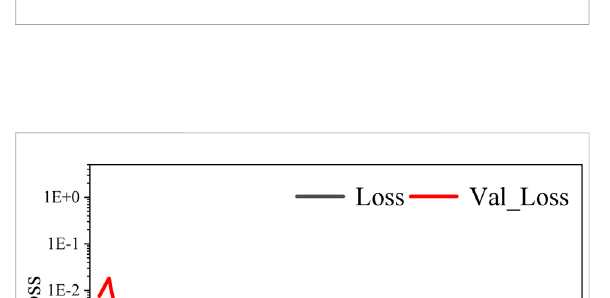
FIGURE 6 Trend of loss value of the training set ( Loss ) and loss value of the veri fi cation set ( Val_Loss ) with the mean square error indicator as the loss function in the 2 input mode.